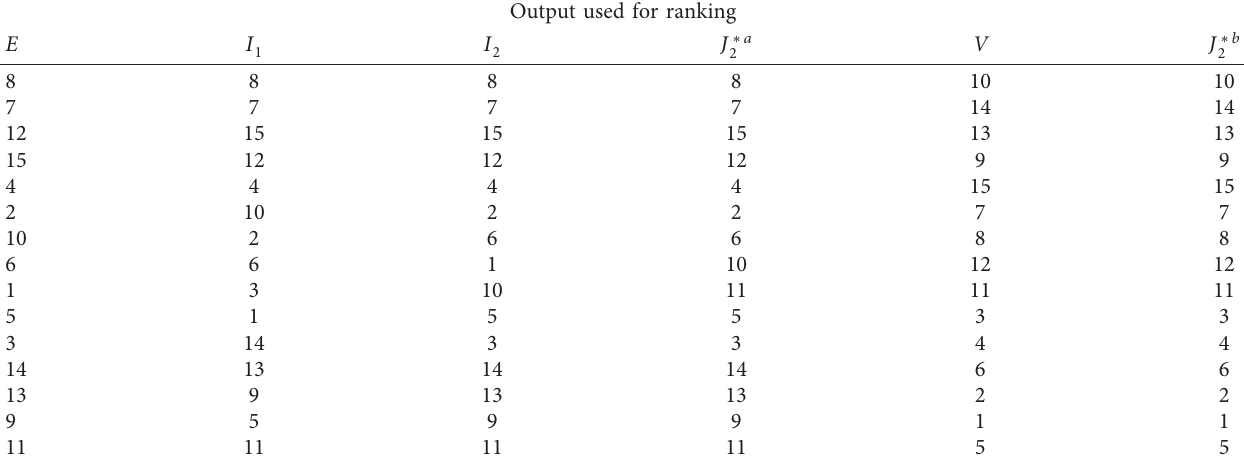
Table 5: Ranking of strategies from most to least cost-effective for various outputs. Output used for